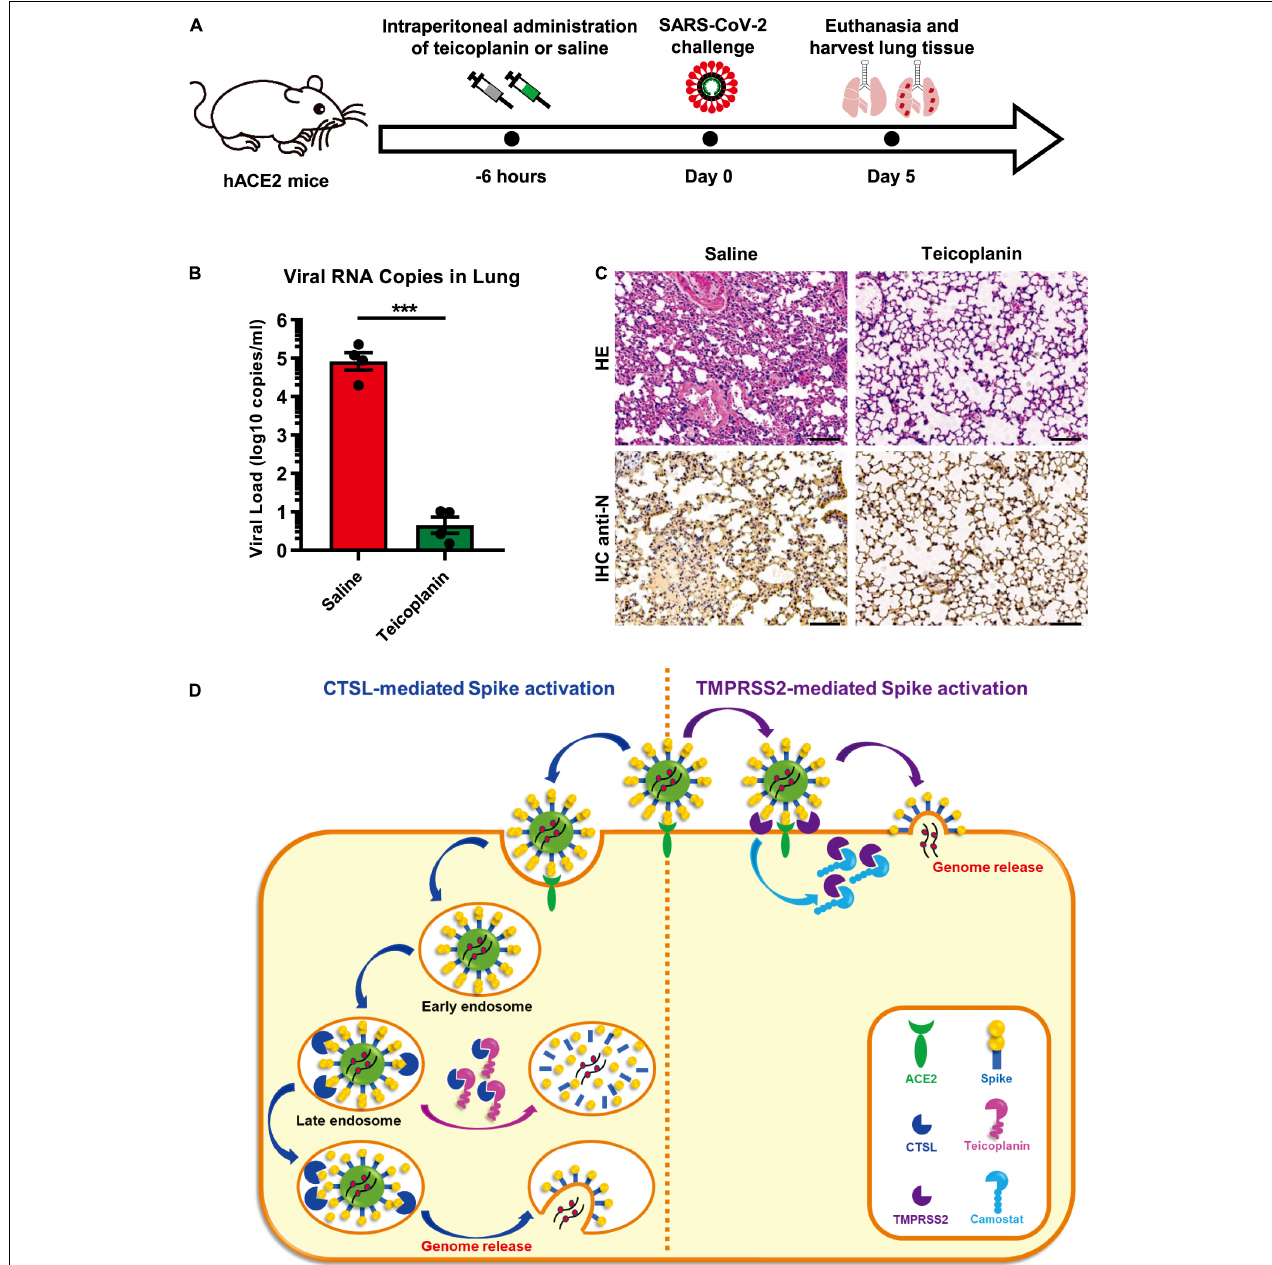
FIGURE 6 | Teicoplanin prevented SARS-CoV-2 infection in hACE2 mice. (A) Schematic of mice experiment procedure. hACE2 mice were intraperitoneally administrated with 100 mg/kg body weight teicoplanin or saline ( n = 4 in each group). Six hours later, each mouse was challenged with 1 × 10 5 FFU of SARS-CoV-2 D614 viruses. Another 5 days later, mice were euthanized to harvest lung tissues which were proceeded to viral RNA detection, HE and IHC. (B) Viral RNA copies in lung tissues of virus-challenged mice were quantified by one-step SARS-CoV-2 RNA detection kit and plotted as log10 copies per ml ( n = 4). The RNA copies data represented biological quadruplicate. (C) Lung tissues of mice from the saline group and teicoplanin group were proceeded to HE staining and IHC with antibodies against N proteins. (D) Schematic of teicoplanin inhibiting the entry of SARS-CoV-2. The SARS-CoV-2 virus binds to the cellular receptor ACE2 by its S proteins which cover the surface of the virus. The S-ACE2 binding event initiates the proteolytic process of TMPRSS2 to S protein on the cellular membrane of CTSL-deficient cells, which triggers the fusion of viral and plasma membranes and subsequently the release of viral genome. Camostat can inhibit the activity of TMPRSS2 and prevent the activation of S proteins, resulting in the inhibition of SARS-CoV-2 infection. In TMPRSS2-deficient cells, SARS-CoV-2 can enter host cells through endocytosis. Within endosomes, CTSL cleaves the S protein and activates the fusion of viral and endosome membranes, resulting in the release of viral genome into the cytoplasm where viruses replicate and assemble. Teicoplanin can effectively block the proteolytic activity of CTSL, rendering the S protein unable to be activated. Without S activation, The SARS-CoV-2 virus is dissolved in the endosome gradually. Scale bars in (C) represented 100 µ m. Data in (B) represented as mean ± SEM in quadruplicate. The P -value was calculated by Student’s t -test. *** p < 0.001.